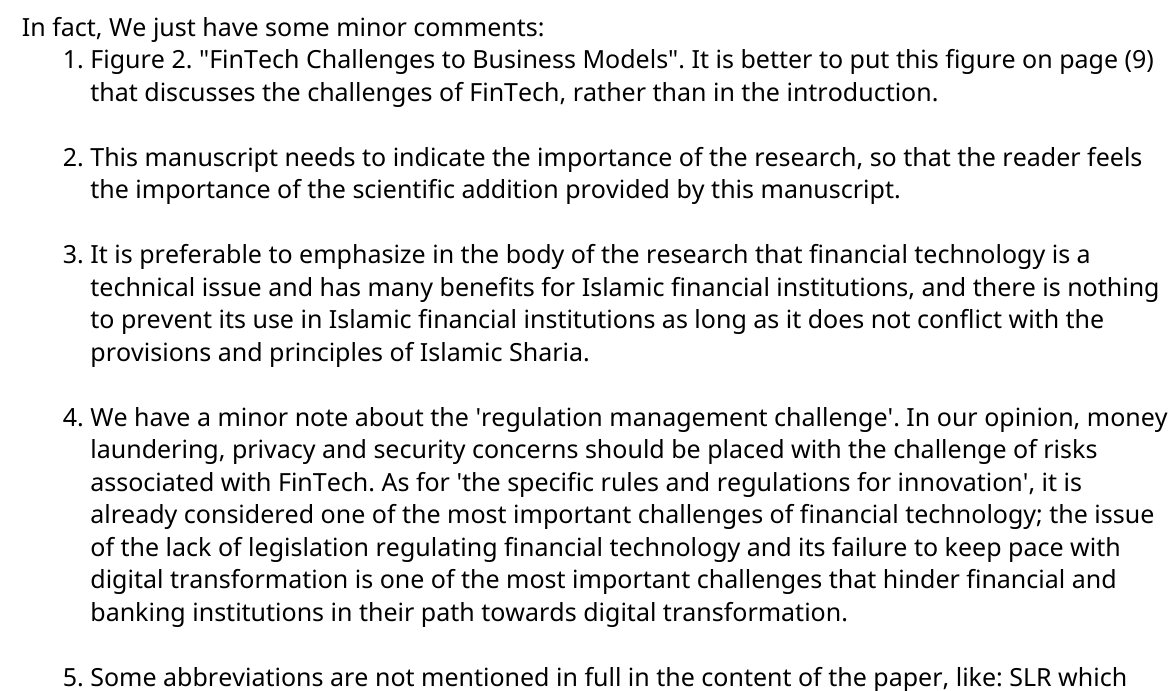
Figure 2. "FinTech Challenges to Business Models". It is better to put this figure on page